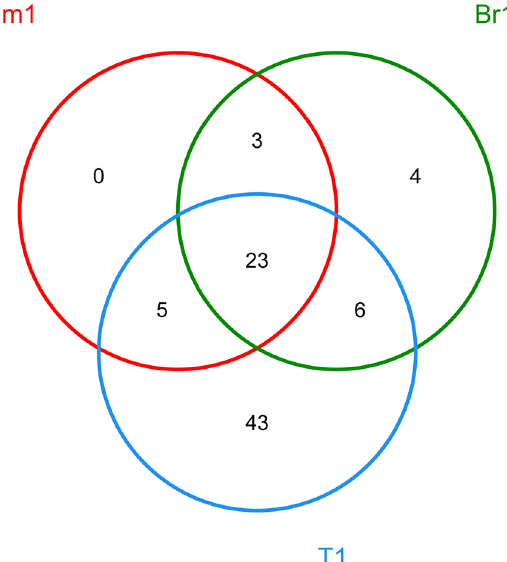
Figure 3. Venn diagram showing the bacterial genera detected in the three different samples m1, Br1, and T1. Overlaps between the samples are indicated by the arrangement of the